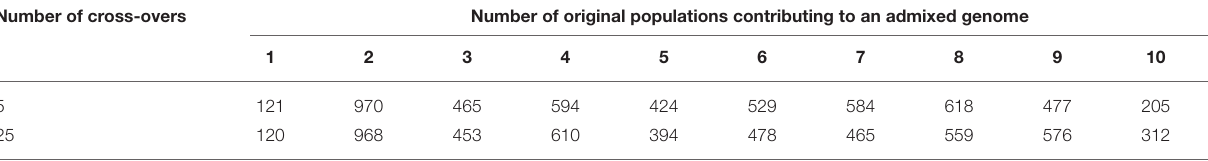
TABLE 1 | Summary of number of admixed animals with genome proportions of 1 to 11 original populations. Number of cross-overs